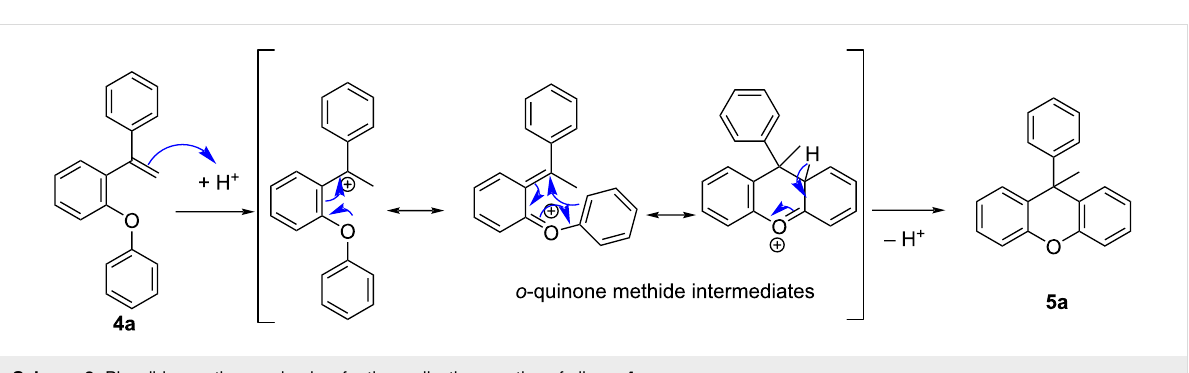
Scheme 2: Plausible reaction mechanism for the cyclization reaction of alkene 4a